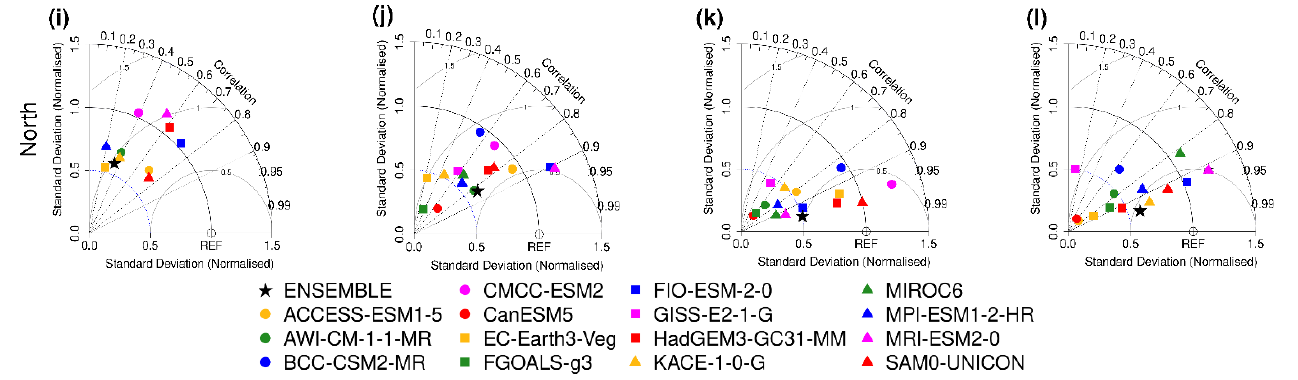
Figure 6. Taylor diagram analysis of seasonal precipitation averaged over the East Coast ( a – d ), Interior ( e – h ), and North ( i – l ) of NEB for 15 CMIP6 models in DJF (first column), MAM (second column), JJA (third column), and SON (fourth column). The term “REF” indicates the reference data from 1980 to 2014.